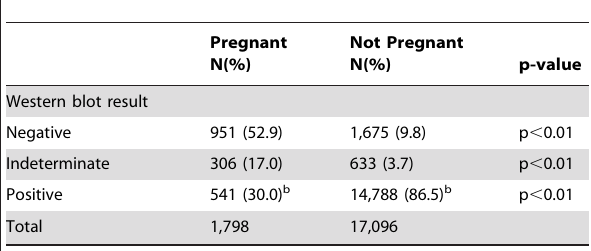
Table 3. Among specimens with a repeatedly-reactive EIA, Western blot result and positive predictive value, by pregnancy status a ; national commercial laboratory, July 2007 to June